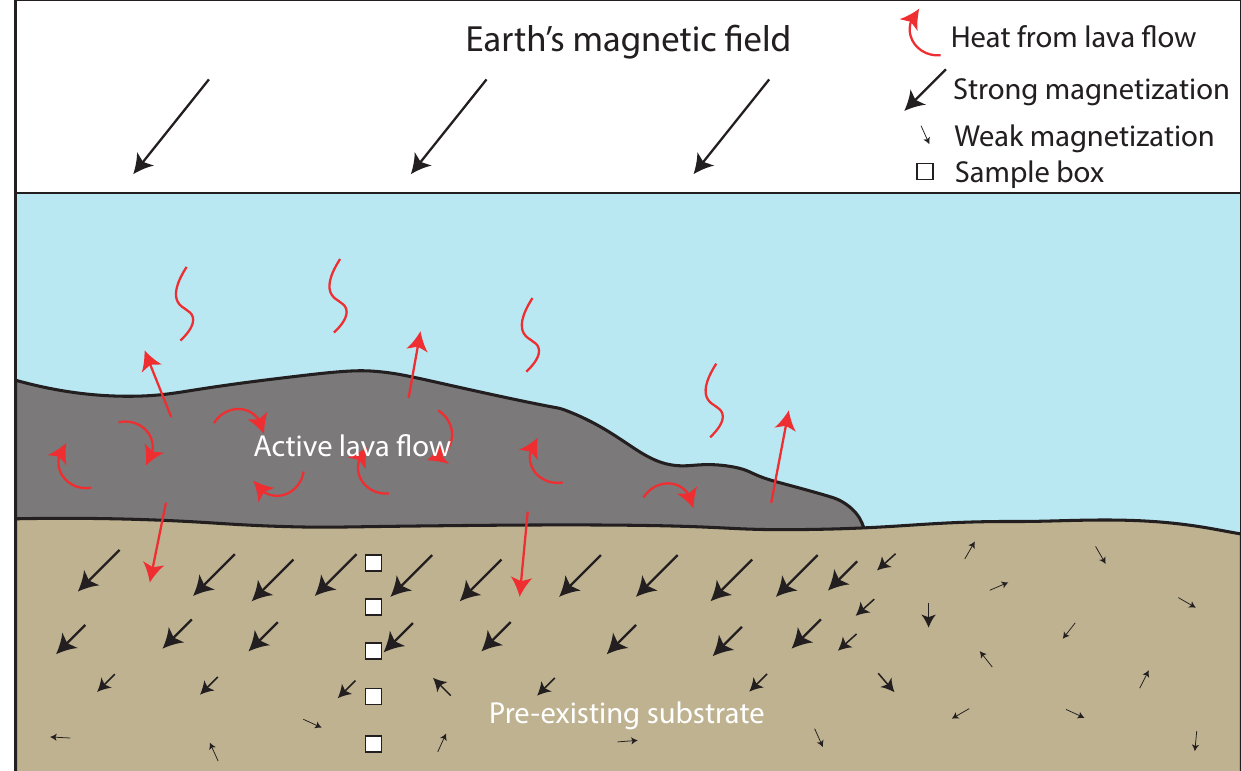
Figure 1: Schematic of lava flow heat transfer and magnetization of adjacent substrates. Red arrows demonstrate the transfer of heat within the lava flow and into adjacent materials. Black arrows demonstrate strong and weak magnetization resulting from reheating of underlying soil by the lava flow. Boxes demonstrate sampling method of taking paleomagnetic box samples at regular intervals of increasing depth beneath the